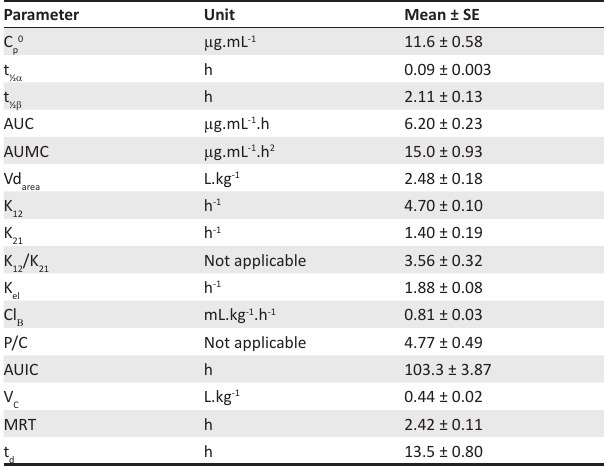
FIGURE 3: Urinary concentration and cumulative percentage of total dose of ofloxacin recovered in urine of water buffalo calves after a single intravenous dose of 5 mg.kg –1 body weight. TABLE 1: Pharmacokinetic parameters of ofloxacin in water buffalo calves ( n = 6) following a single intravenous dose of 5 mg.kg -1 body